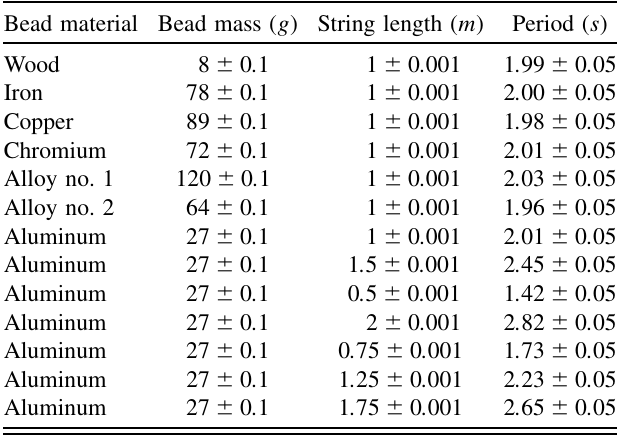
TABLE VI. Oscillation period for different beads and various string